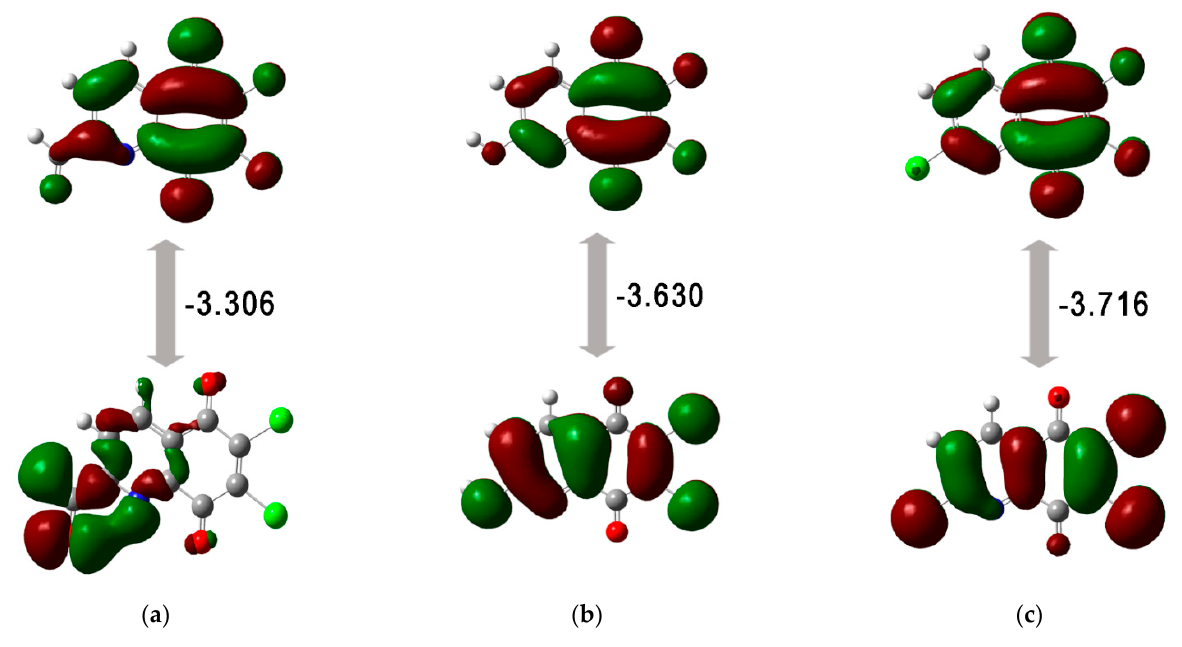
Figure 3. The arrangement of orbitals for compounds: ( a ) 3 , ( b ) 6 , ( c ) 7 . The tested compounds show the energy gap ( Δ E) ranging from − 3.306 to − 3.716 eV, which means that they can exhibit high reactivity towards the biological target [46]. The type of substituent at the C2 position of 5,8-quinolinedione slightly influences the energy gap ( Δ E). The quantum chemical descriptors are presented in Table 3.